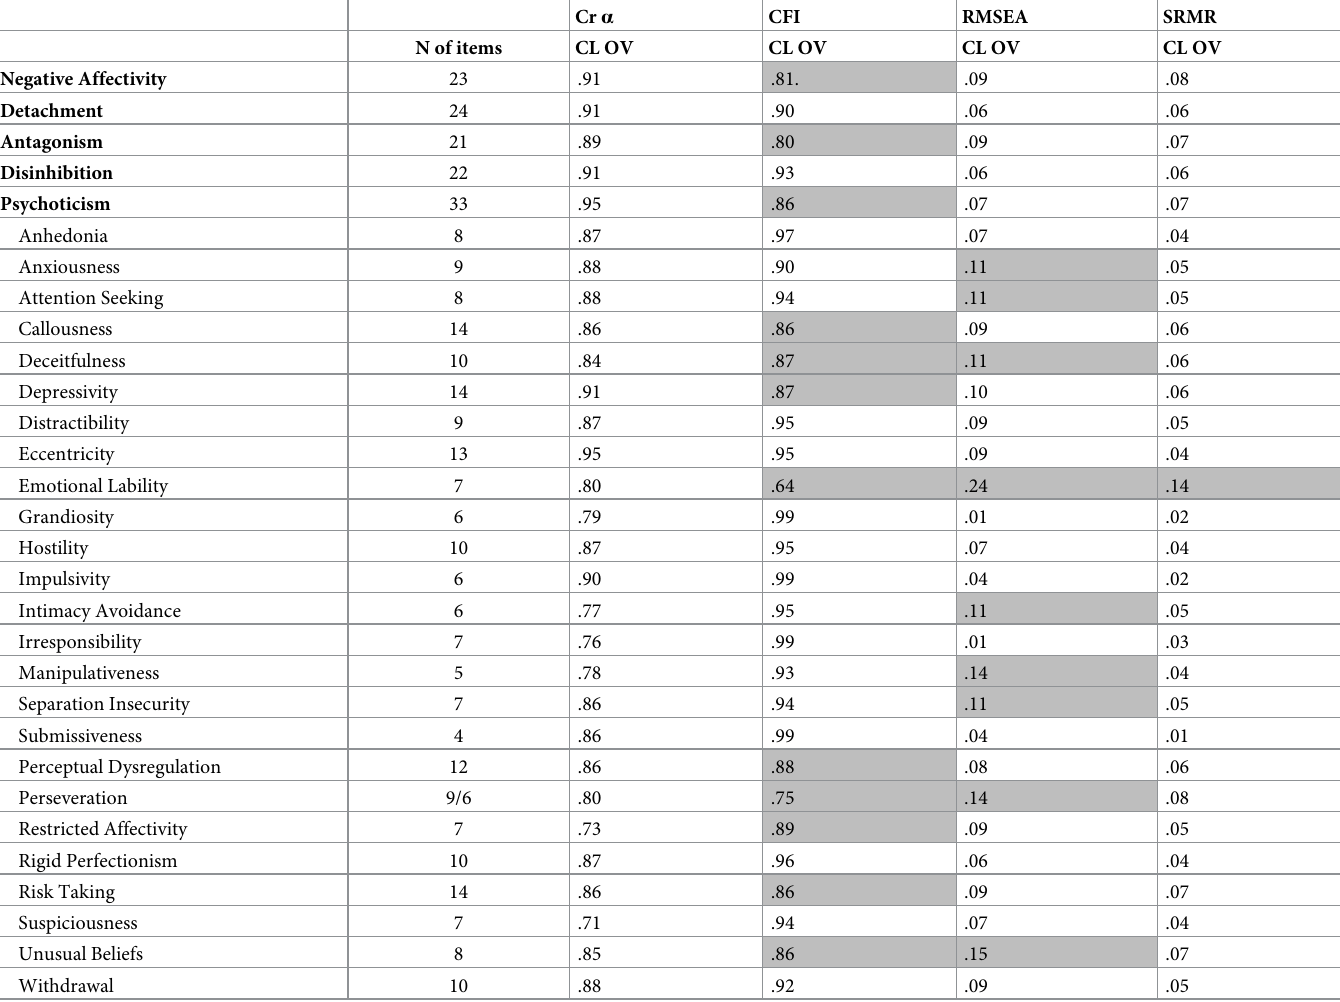
Table 5. Internal consistency and item level CFA of Personality Inventory for DSM-5 scales on clinical